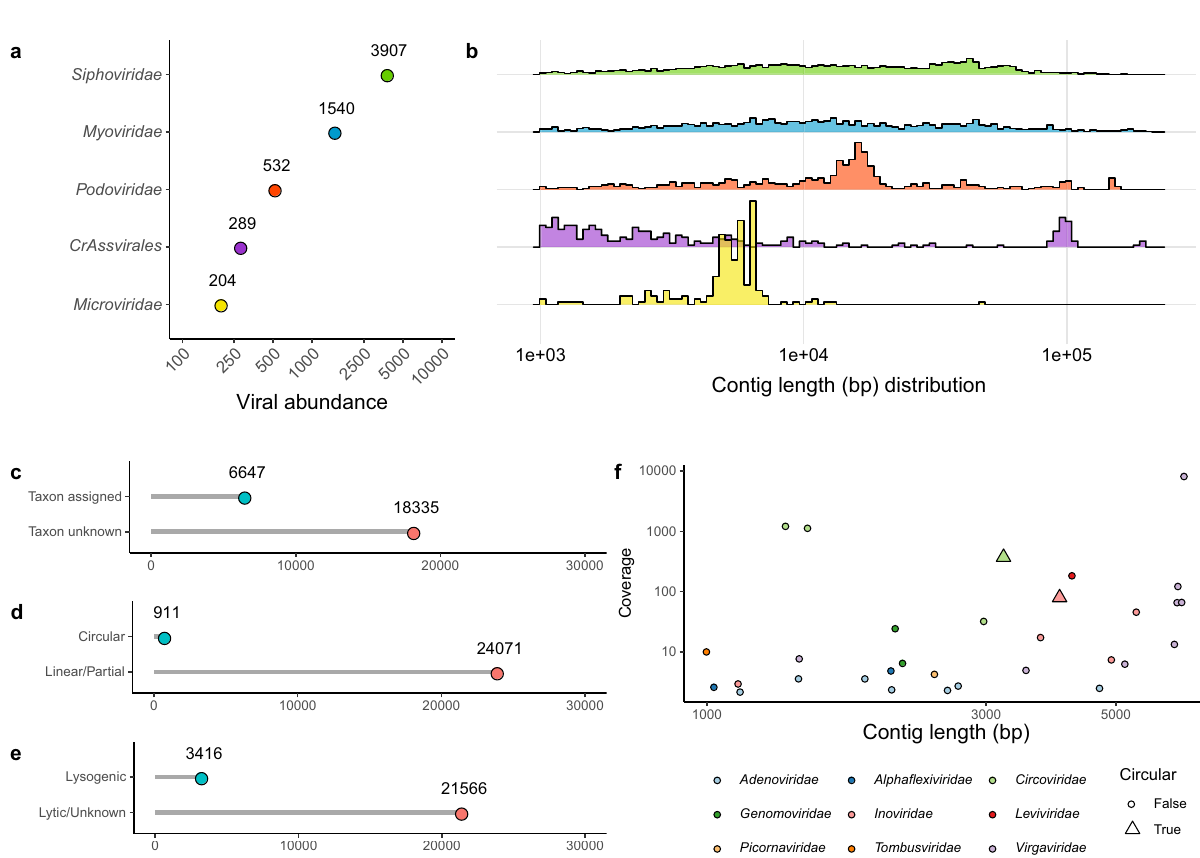
axis as disease separation (Fig. 2c, d). To highlight this result